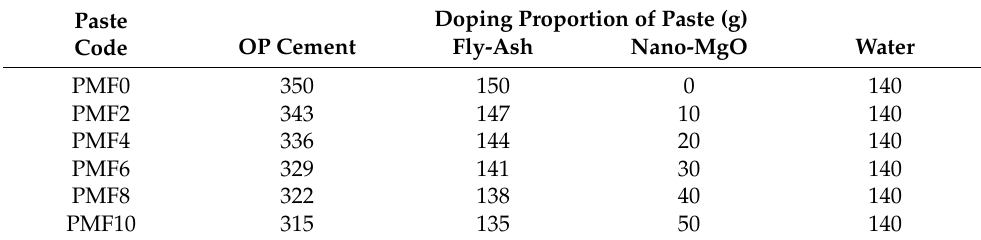
Table 2. Doping ratio of cement